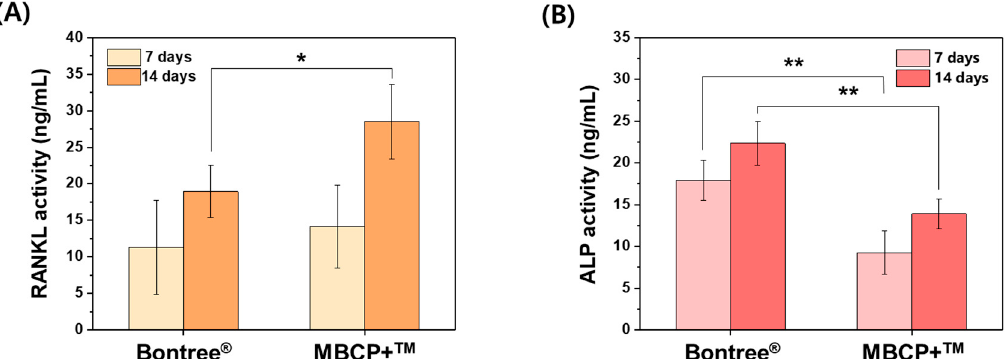
Figure 2. ( A ) RANKL activity and ( B ) ALP activity of MG63 cells in Bontree ® and MBCP+ TM cultures after 7 and 14 days of culture. Statistical significance was set at * p < 0.05 and ** p < 0.01, respectively. RANKL, receptor activator of NF- κ B ligand; ALP, alkaline phosphatase.